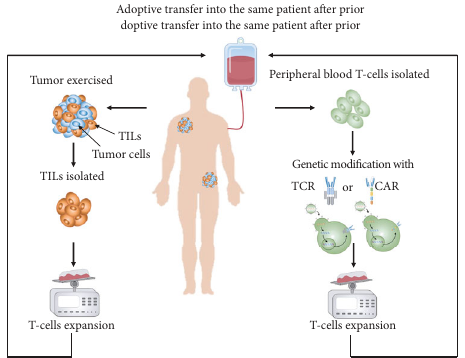
Figure 3: The mechanism of adoptive cell therapy. ACT with TILs separates TIL cells from tissues near the tumor, and large-scale expand in vitro, then reintroduce into the patient. ACT with TCR or CAR separates T cells of patient peripheral blood and is genetically modi fi ed to express TCR or CAR, then it can speci fi cally recognize and attack tumor cells when reinfused into the patient. Before the adoptive transfer to the patients, they are treated with a lymphodepletion adjustment